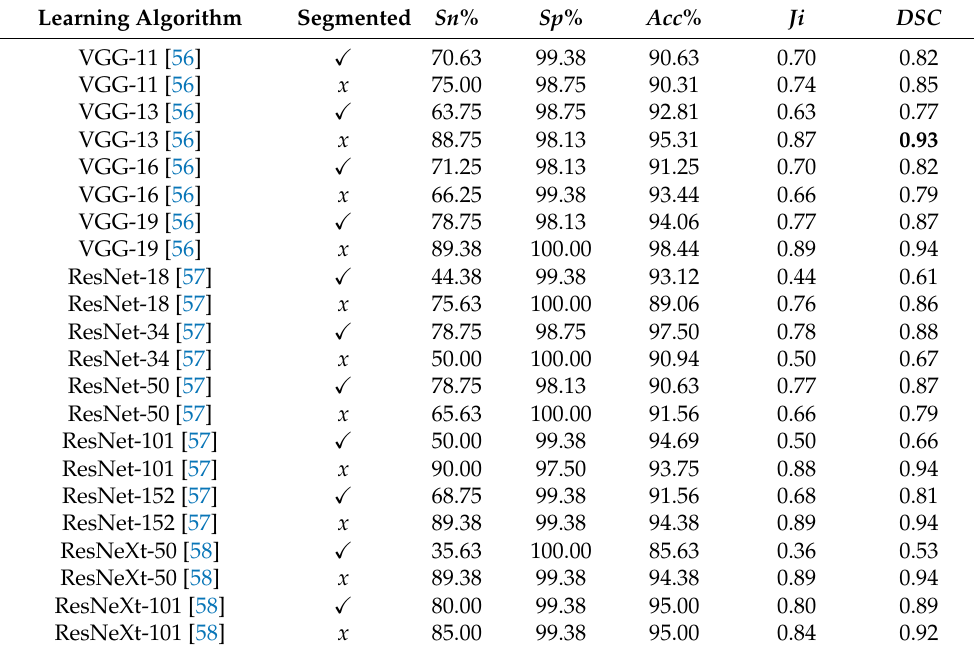
Table 5. Binary classification of malignant skin lesions.